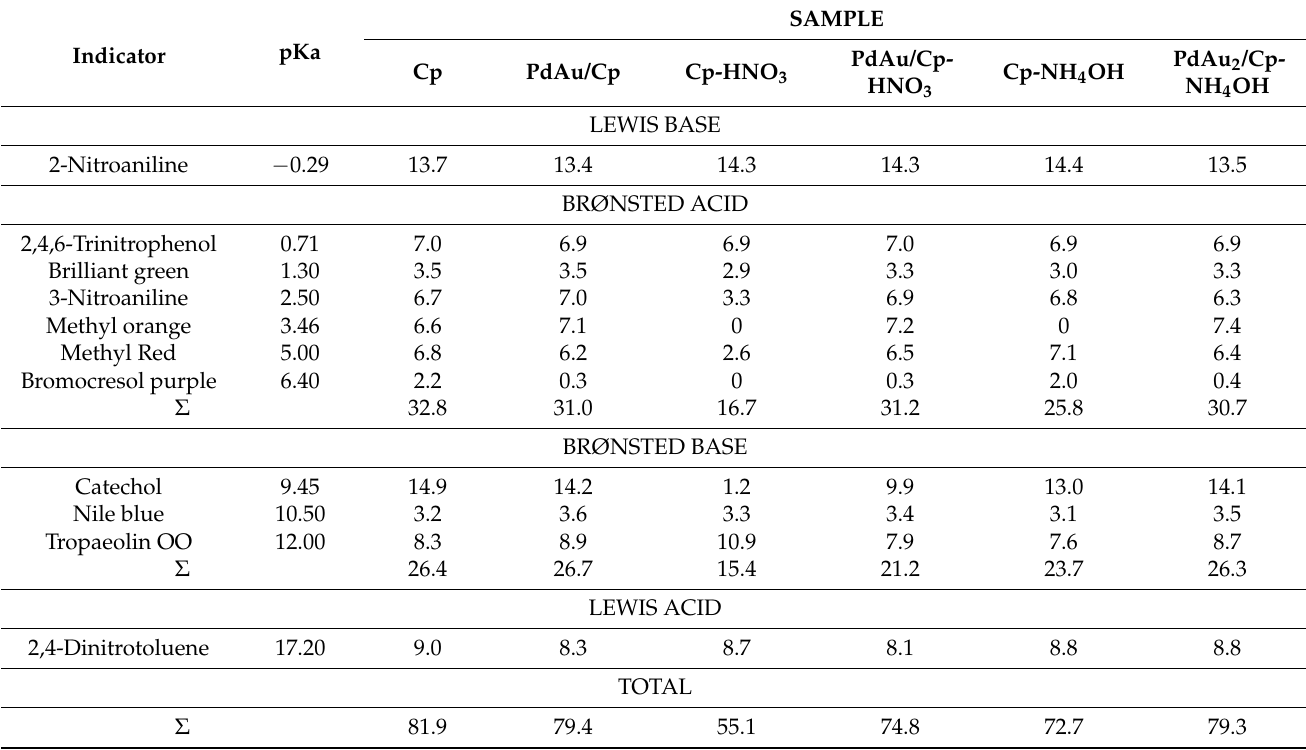
Table 10. The content of acid-base centers on the surface of the studied catalysts and corresponding supports (q, µ mol/g).